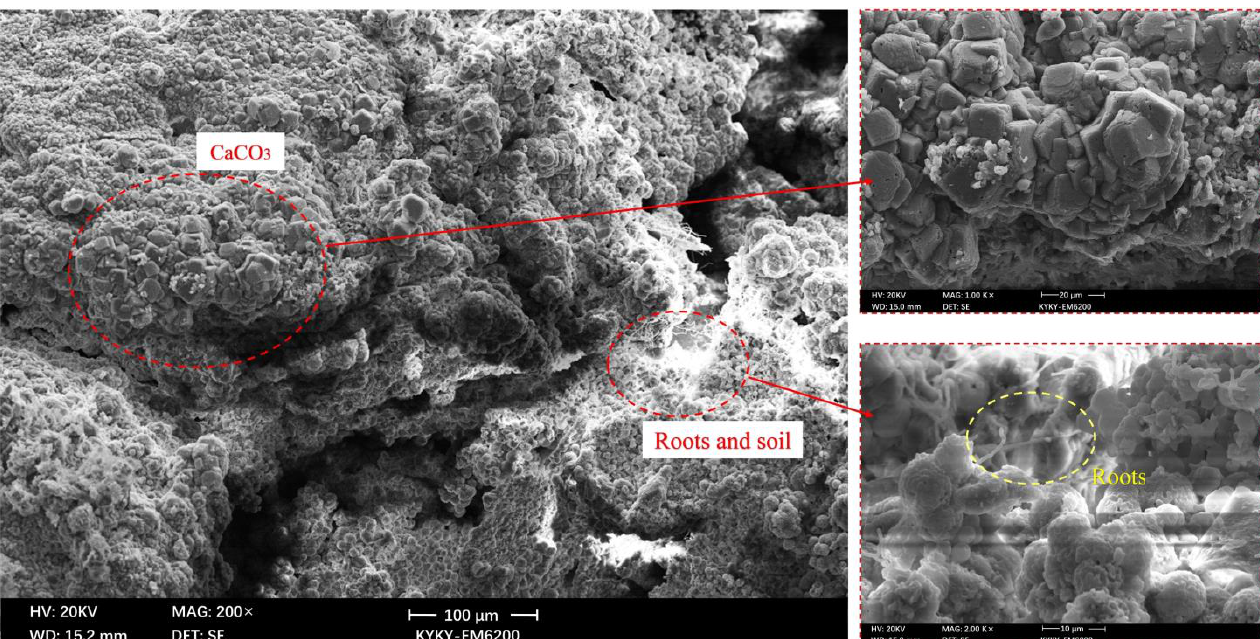
Figure 9. SEM microstructure of soil samples after MICP treatment.